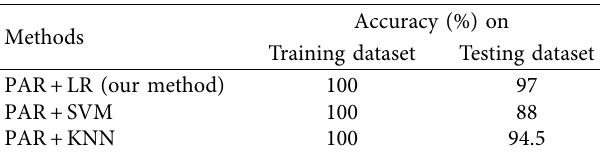
Table 4: The classification accuracy on the testing dataset using the PAR of the time-varying loudness spectrum and logistic regression